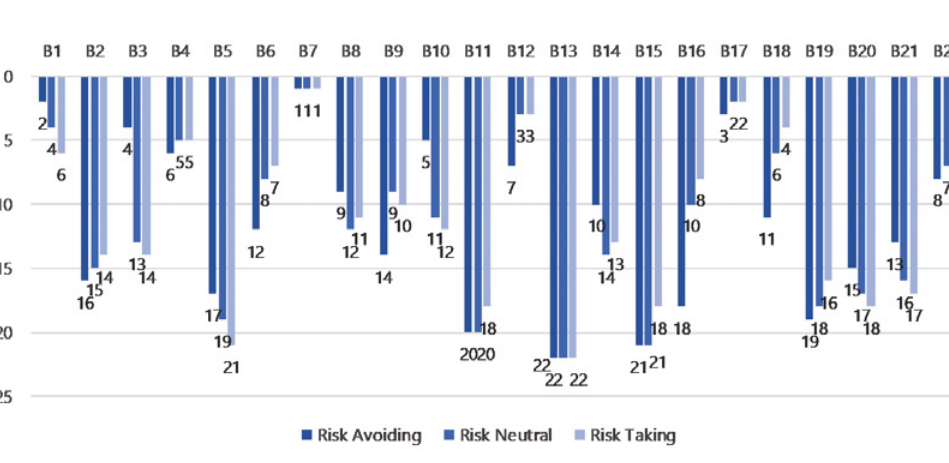
Figure 5. Ranking of bridges with three risk